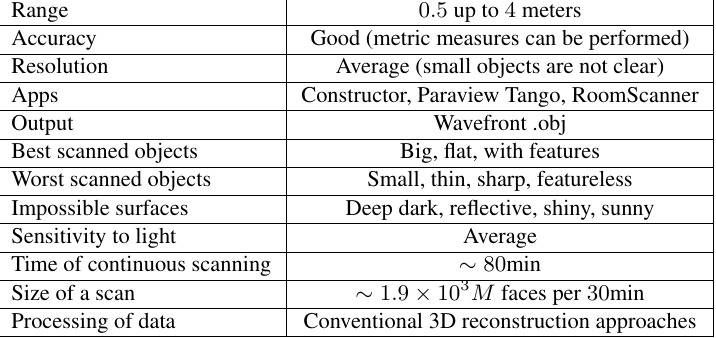
Table 1: Summarizing table of the capabilities of the Tango Tablet.